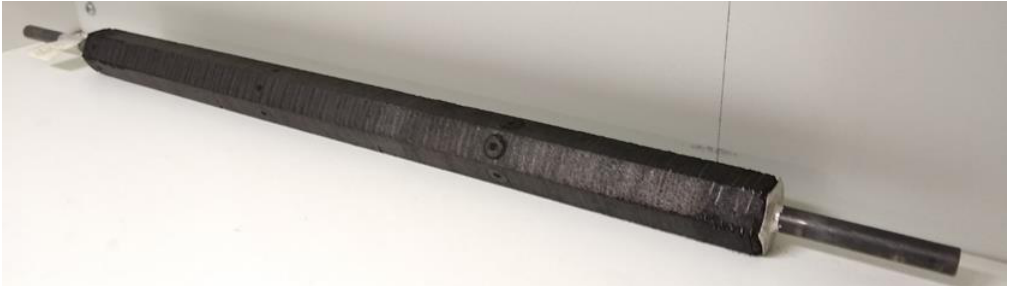
Figure 7. Completed aluminum–carbon laminate tube module.